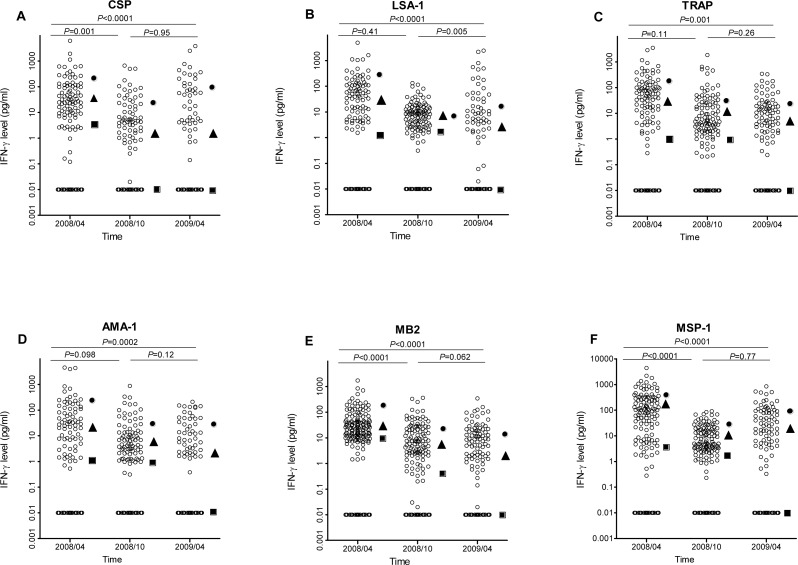
IFN-γ levels in response to P. falciparum antigens at baseline (April 2008), October 2008, and April 2009.For each antigen, only individuals with a positive response in at least one time point were included in the analysis. The respective N values for the antigens were 144, 165, 169, 142, 194 and 183, respectively, for CSP, LSA, TRAP, AMA, MB-2 and MSP-1. The median IFN-γ level at each time is indicated by a square, 90th percentile by a circle, and 75th percentile by a triangle. Non-responders are placed below responders by giving them an artificial level of 0.01 and then “jittering” their levels (adding random noise) vertically to give an accurate sense of the number of non-responders.